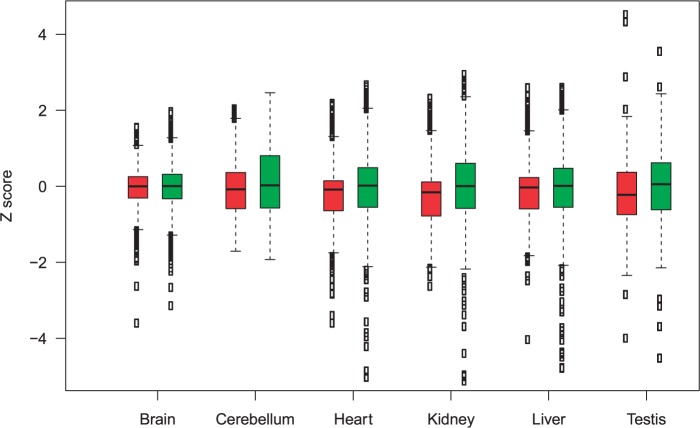
Z scores of genes in and out of lamina domains across six tissues. All pairwise comparisons are highly significant (before multitest correction, Mann–Whitney U test P < 10−9 except brain P = 4 × 10−4). Z score of the genes on Lamina domains are shown with boxplots in red and the rest are in green. Genes with very high or very low Z are excluded from the plot as outliers to improve presentation but have been included in Mann–Whitney U test.